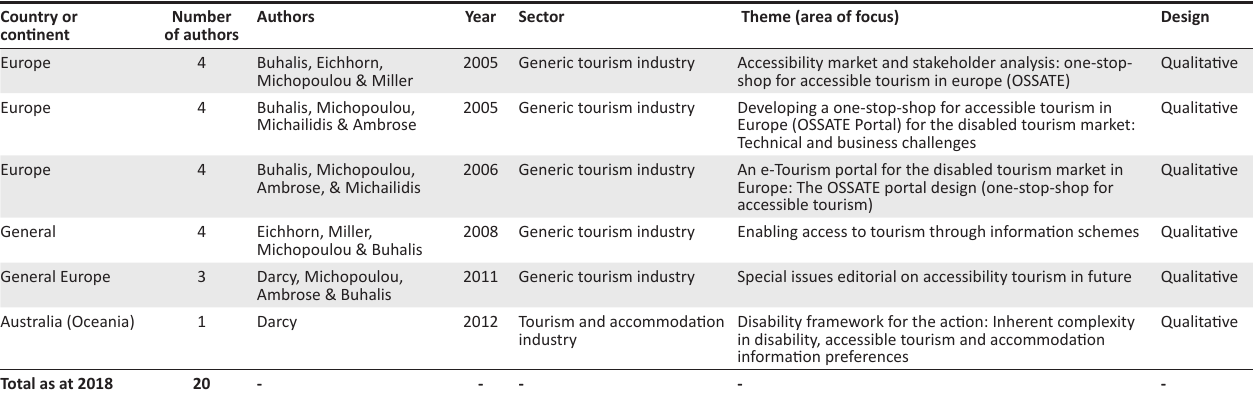
TABLE 7: Research on the technology development of disability tourism (in sequential order of year, from 1990 to 2018). Country or